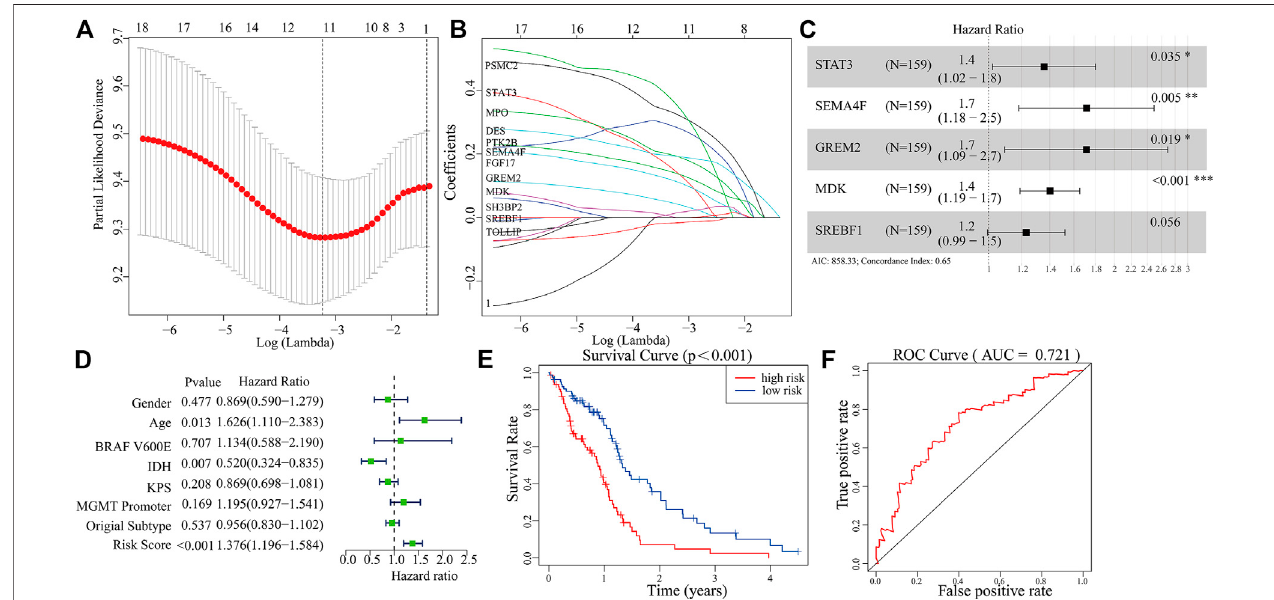
FIGURE 4 | Construction of a prognostic model based on the 289 genes of the MEblue module in the training set. (A,B) Twelve survival-related genes by LASSO penalized regression. (C) Five potential prognostic genes via multiple Cox regression with LASSO penalty. (D,E) Prognostic classi fi er analysis of the patients in the internal testing set. (F) ROC curve of the potential prognostic genes.